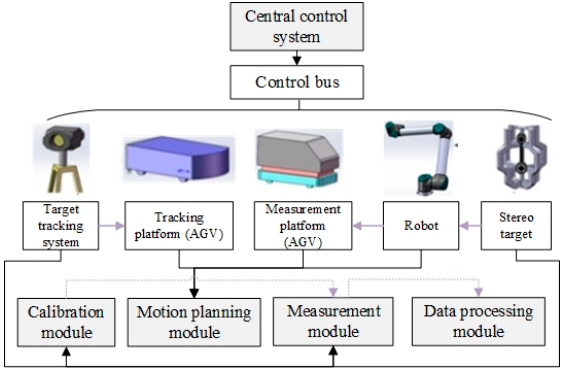
Figure 3. Schematic diagram of software platform